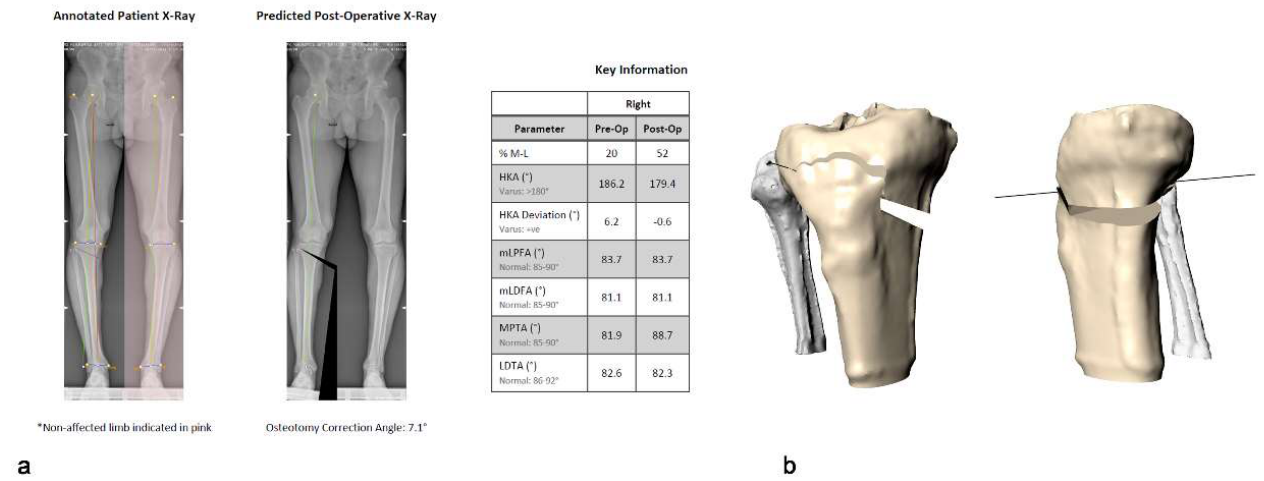
Figure 2. ( a ) 2D planning based on the pre-operative weight-bearing long leg radiograph. ( b ) The location and angle of the main incision together with any desired change in posterior tibial slope (PTS) were selected using the 3D CT data.